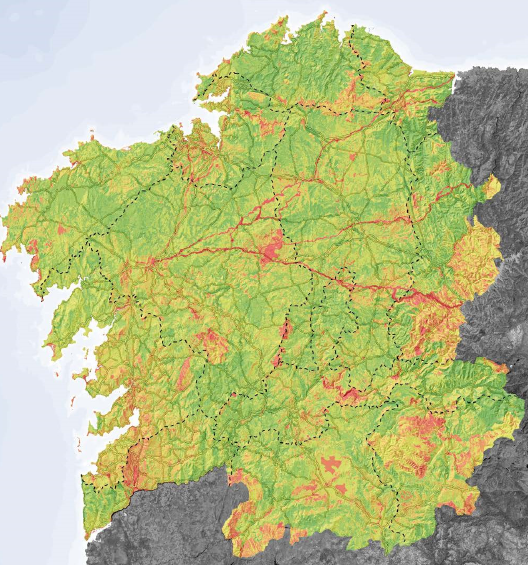
Figure 2. Landscape evaluation map of Galicia (Red: High values; Green: Low values).